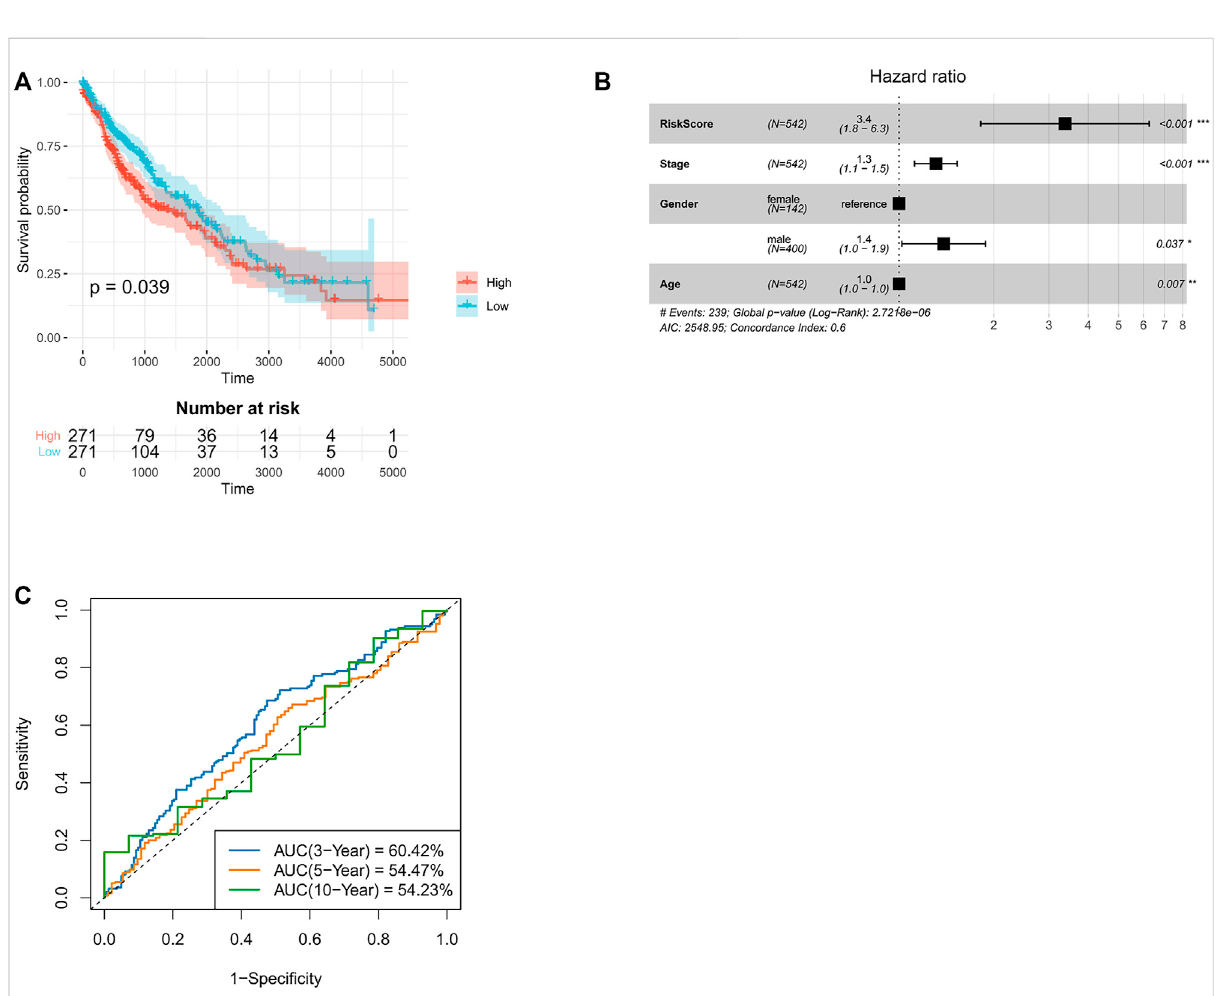
FIGURE 2 Validation of TANlncSig in TCGA lung squamous cell carcinoma discovery and testing datasets. (A) Kaplan-Meier survival analyses of lung squamouscell carcinomapatients. (B) Multivariate Coxregression analyses ofpatients with LUSCbased onTCGA dataset. (C) ROC curveanalyses of patients with LUSC using the TCGA